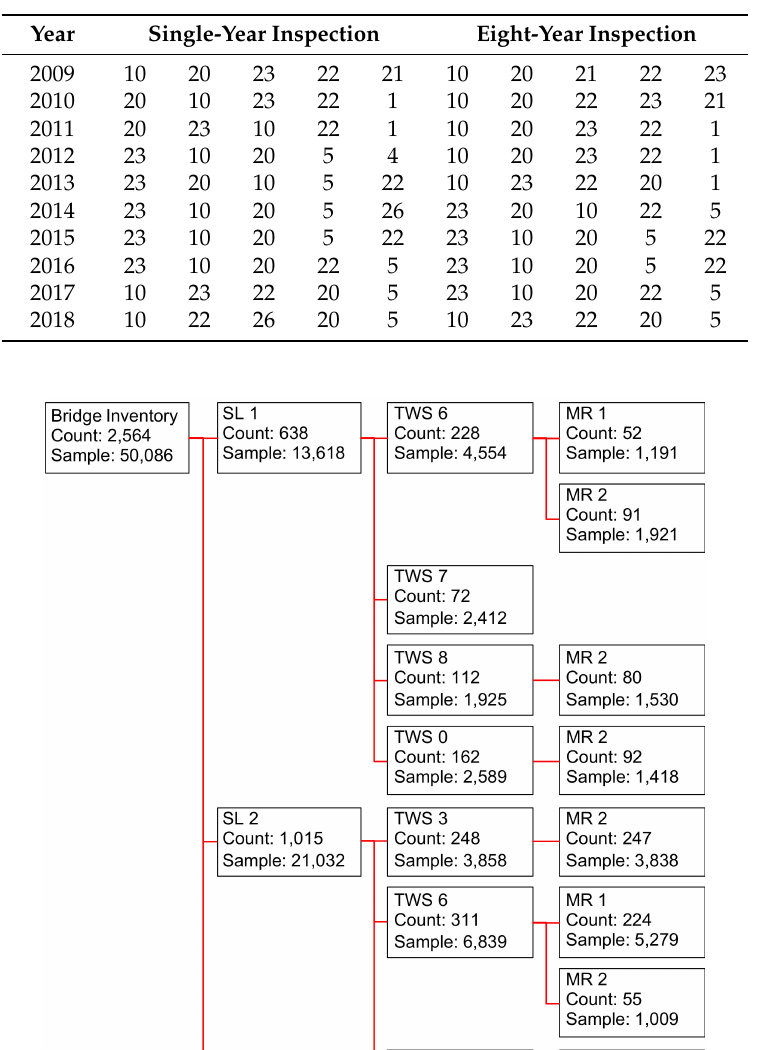
Table4. Listofexplanatoryvariablesforsubstructuresince2009usingLASSOwithandwithoutweights.